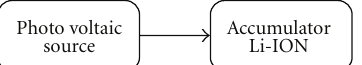
Figure 1: Direct connection from photovoltaic panel to accumula- tor battery.